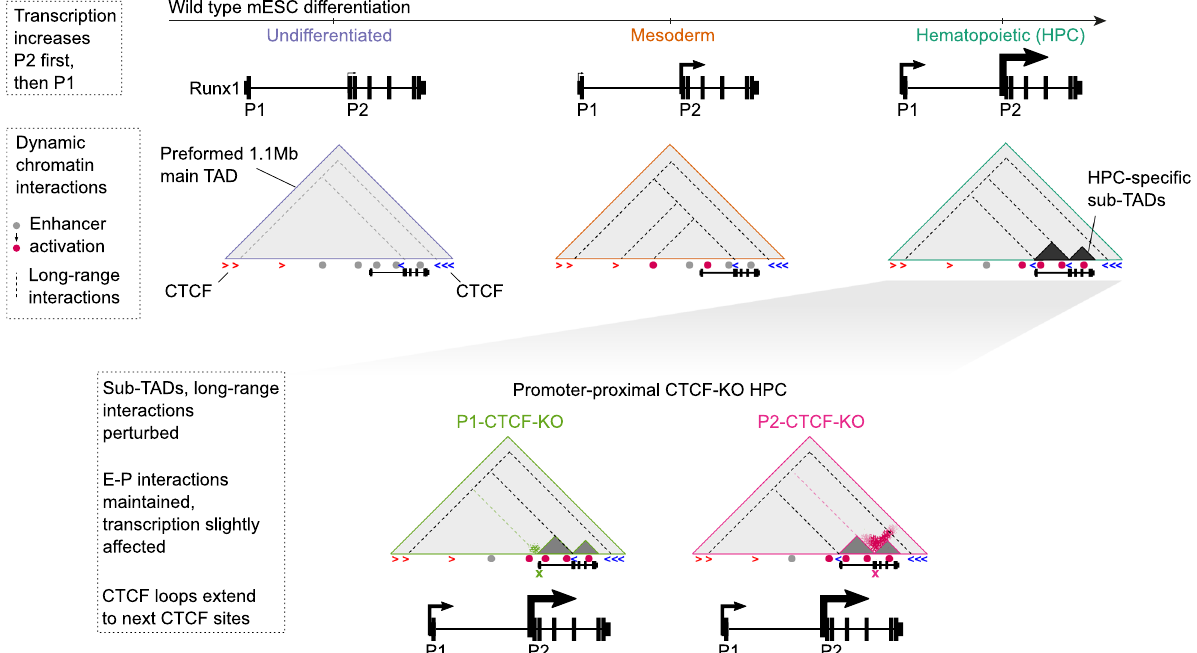
Fig. 6 Schematic model of dynamic chromatin changes at Runx1 during hematopoietic development and after promoter-proximal CTCF site deletions. Large light gray triangles represent the preformed main 1.1 Mb Runx1 TAD. The orientation of selected CTCF motifs is indicated below the TAD. Selected previously identi fi ed enhancer elements in each cell type are represented by gray circles (inaccessible) or red circles (accessible). Dashed lines throughout the TAD represent long-range chromatin interactions, with the darker color indicating a stronger interaction. Hematopoietic progenitor cell (HPC)-speci fi c sub-TADs over the Runx1 gene are indicated by dark gray smaller triangles within the larger TAD. A larger schematic of the Runx1 gene is shown in each cell type with larger arrows at each promoter representing more transcription from that promoter. P1 and P2-CTCF-KO interactions in HPCs are indicated in the bottom two triangles, with the location of the deleted sites indicated by green and pink crosses. The lighter sub-TAD triangles over the Runx1 gene indicate reduced sub-TAD insulation after promoter-proximal CTCF site deletion. The green and pink colored areas in the TAD represent increased interactions compared to wild type after deletion of P1-CTCF and P2-CTCF, respectively. The lighter green and pink dashed lines represent reduced long-range interactions from the promoters after P1 and P2-CTCF site